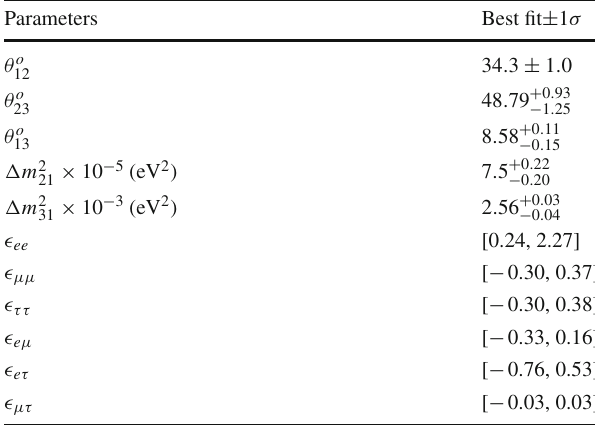
Table 1 Standard neutrino oscillation parameters and NSI parameters [65] in 1 σ interval. Here NSI parameters are assumed to be real.